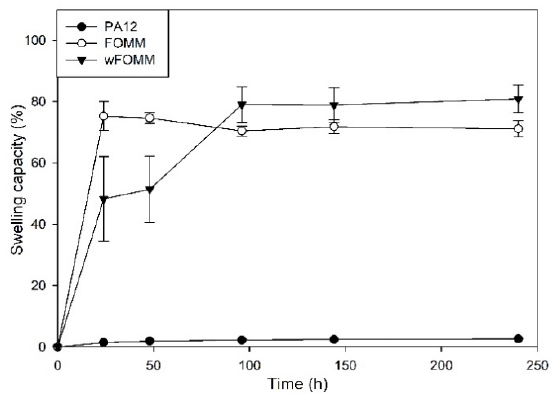
Figure 7. SC of the studied filaments. Results are presented as mean ± SD.